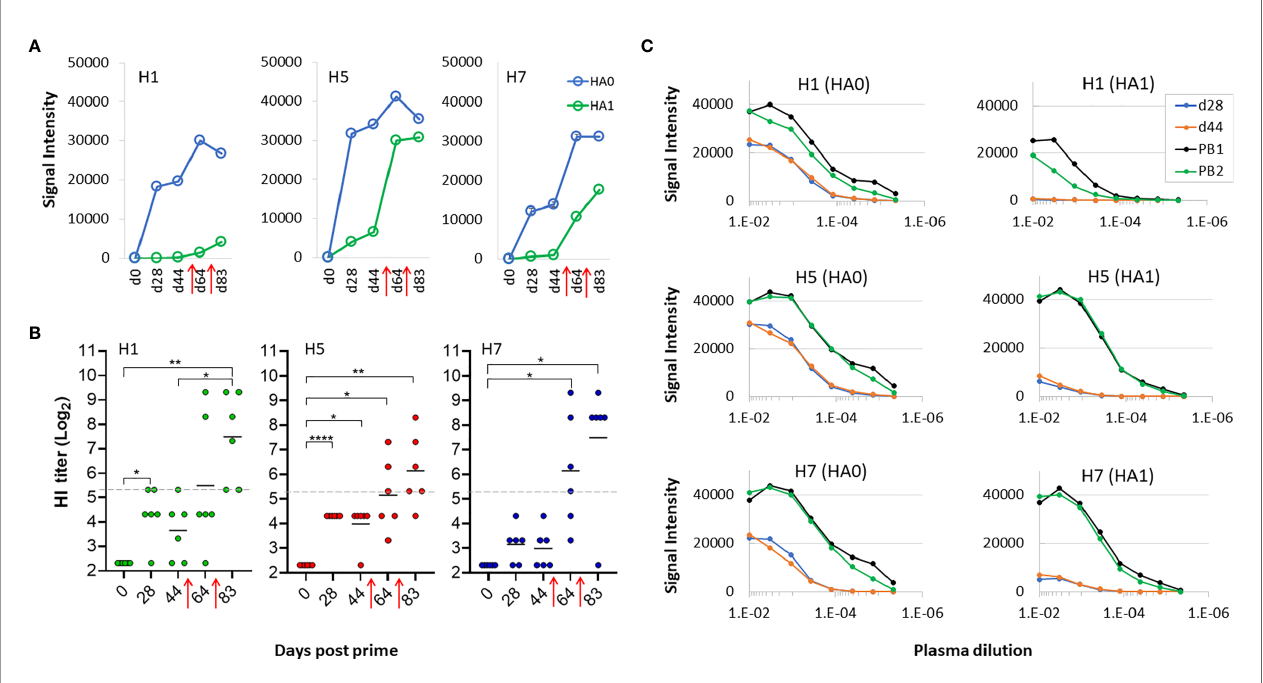
FIGURE 6 | Boosting is required to generate virus neutralization after receiving trivalent vaccine. (A) Means of signals at different time points for HA0 and HA1 variants of H1, H5 and H7 after administration of trivalent vaccine. (B) HI assay titers of individual sera used in panels (A, B) against PR8 reassortant in fl uenza viruses expressing Cal09 H1, VN04 H5 and AH13 H7, respectively. Horizontal dotted line, 1/40 dilution cutoff (log-2 of 40 = 5.32) (C) serial dilutions of plasma from a representative mouse to determine titers at different time points using microarrays; shown are means of H1, H5 and H7 variants after serial dilutions. All data are representative of two separate experiments. PB1, post fi rst boost; PB2, post second boost; red arrows, boosts. ****P < 0.0001; ***P ≤ 0.001; **P ≤ 0.01; *P <